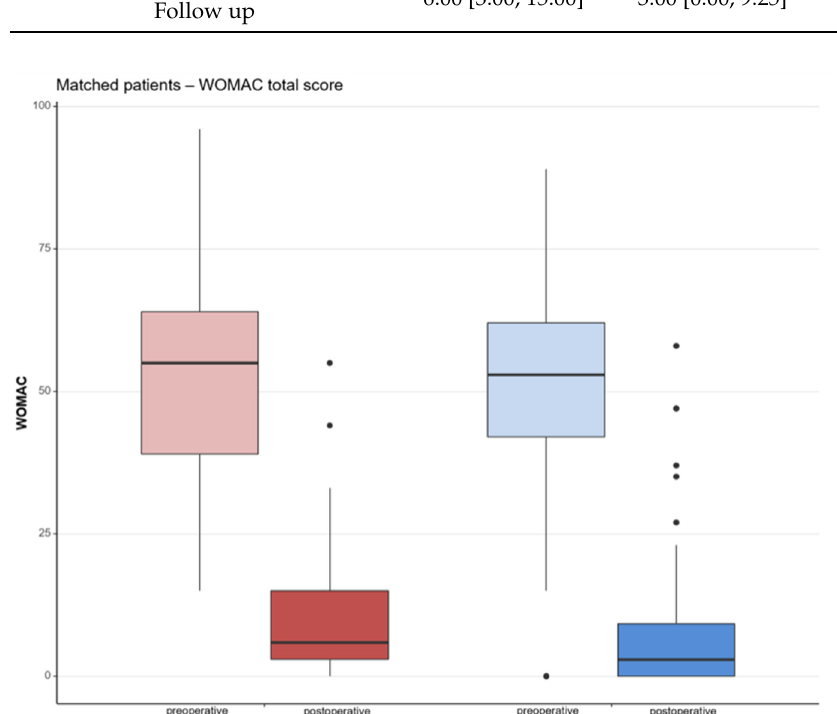
Figure 2. WOMAC Score (Western Ontario and McMaster Universities Osteoarthritis index) at the time preoperatively (pre) to 12 months postoperatively (post). Shown in red color: non-ERAS group; in blue color: ERAS group.